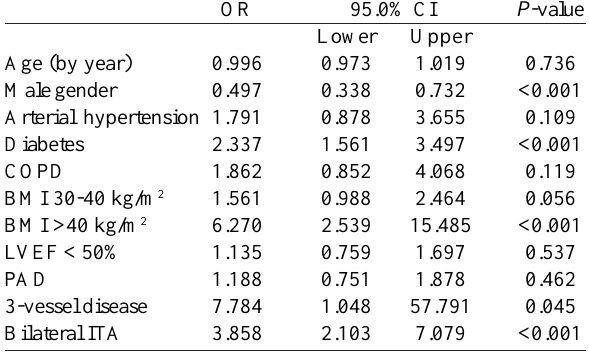
Table 3. Microorganisms Associated with SWI. Type of microorganisms Coagulase-negative